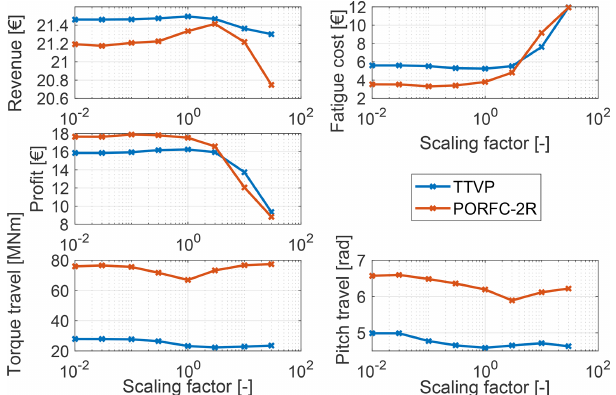
Figure 7. Variation in KPIs depending on the scaling of moving mean filter window length.